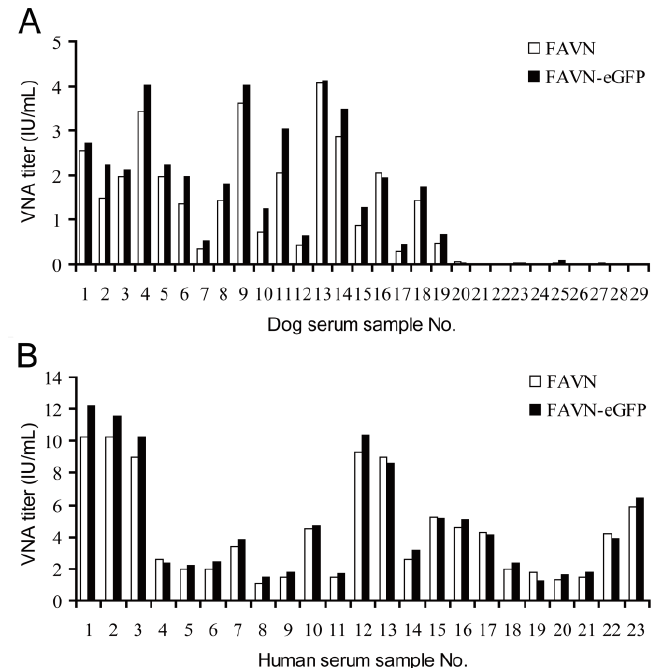
Figure 4. Comparison of rabies VNA titers determined with rCVS-11-eGFP and wtCVS-11. ( A ) Nineteen positive serum samples from vaccinated dogs (No. 1–19) and ten negative dog serum samples (No. 20–29) were assayed for rabies VNA titers using wtCVS-11 and rCVS-11-eGFP; ( B ) Twenty-three positive human serum samples from volunteers (No. 1–23) were assayed in the same manner as above. The results obtained with the two viruses were compared using a paired t-test, and no significant difference was